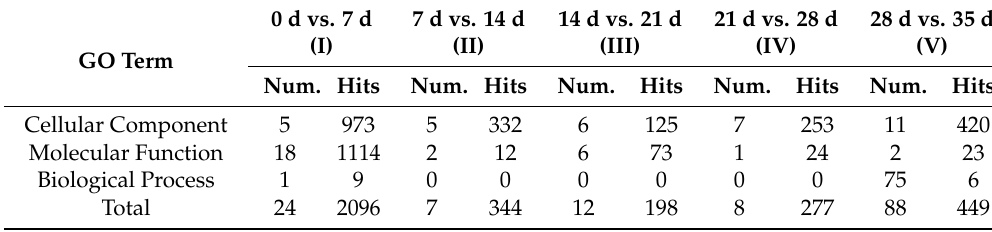
Table 1. Gene ontology (GO) terms enrichment